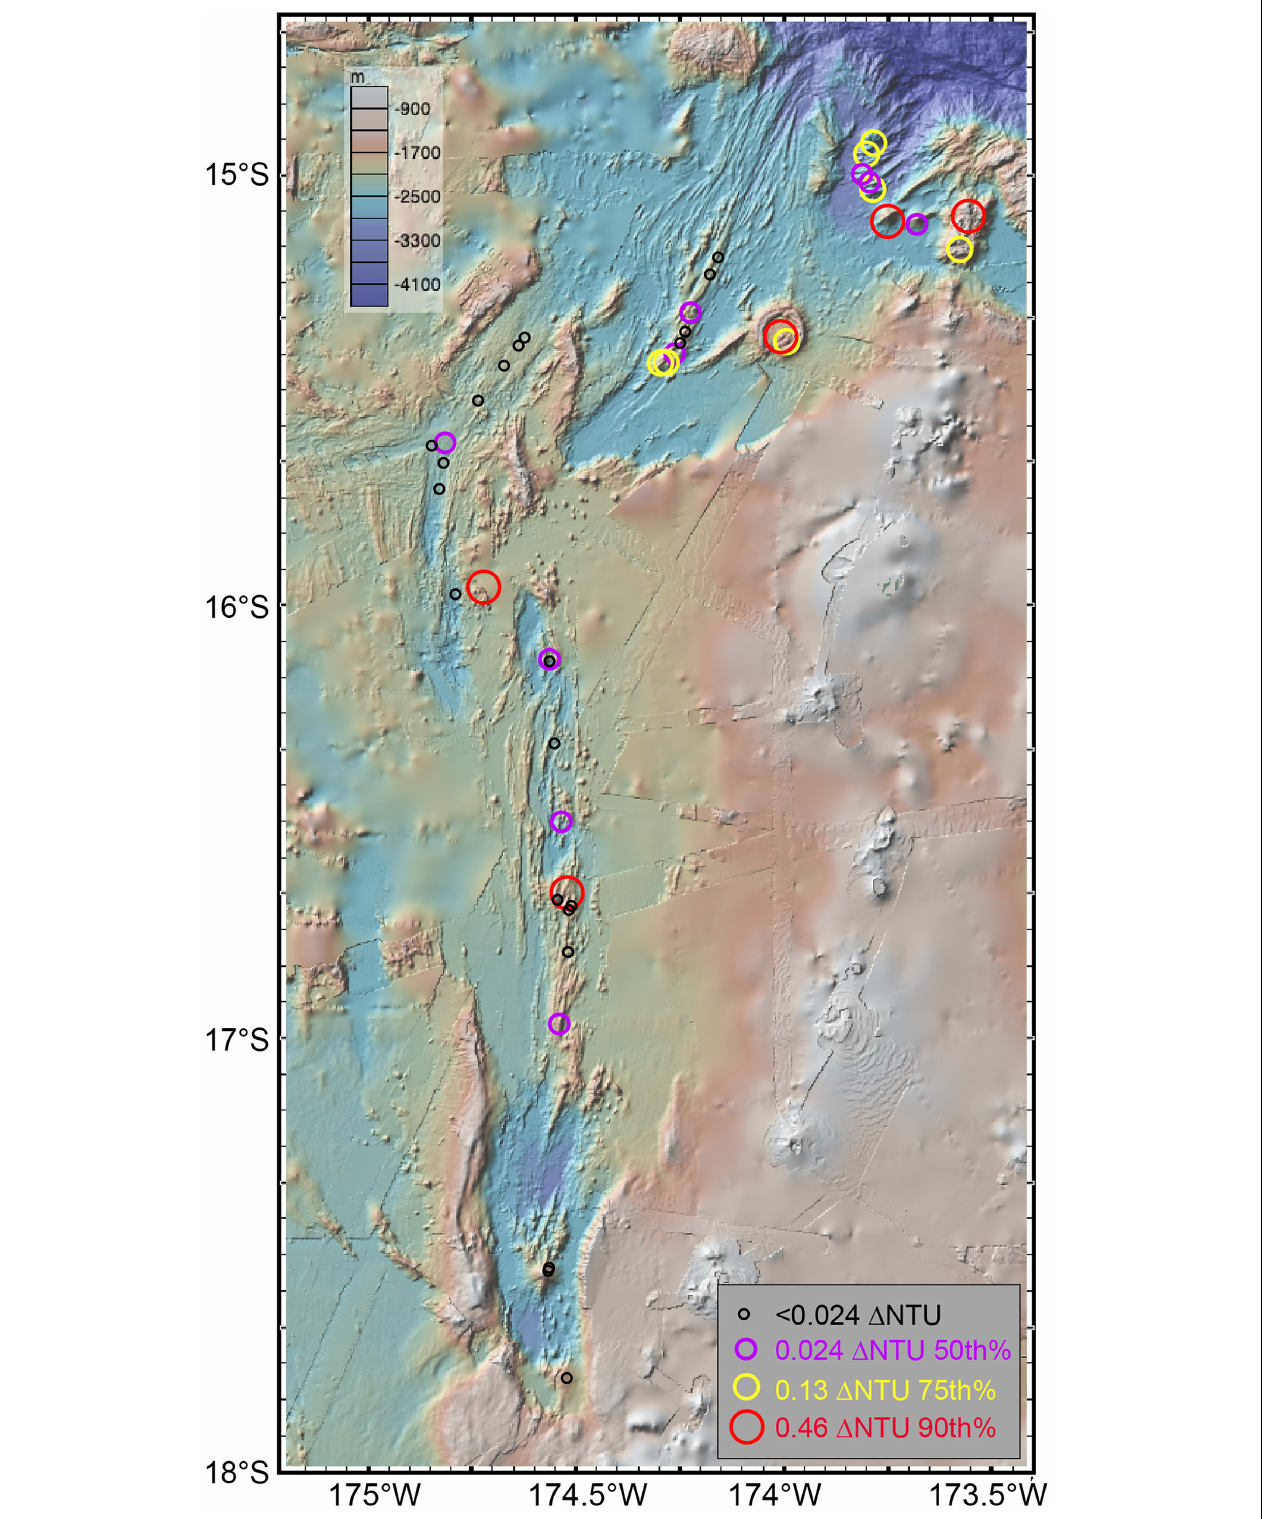
FIGURE 5 | Distribution of maximum (cid:49) NTU at each site: ≥ 90th percentile (red), ≥ 70th–90th percentile (yellow), ≥ 50th–70th percentile (lavender), < 50th percentile (black). Values given in Tables 1 , 2 . Figure made with GeoMapApp (www.geomapapp.org).